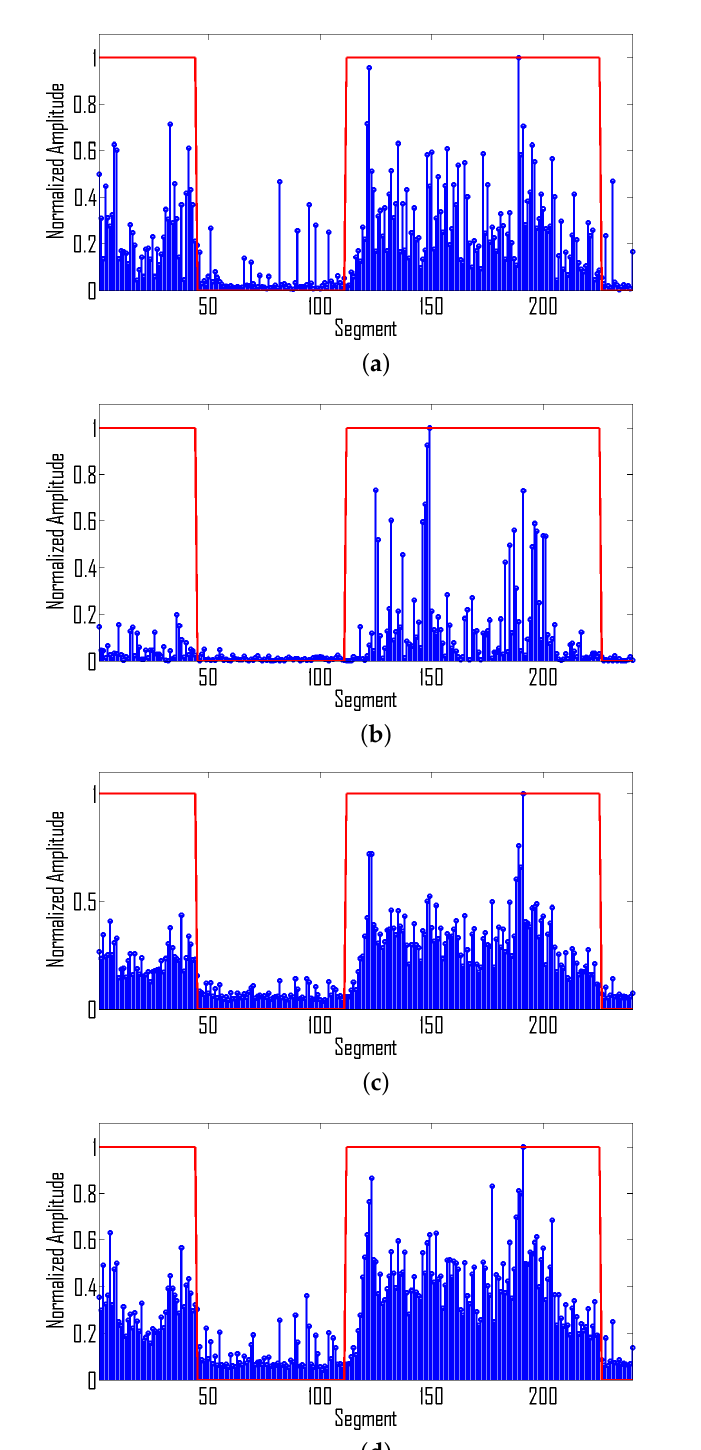
Figure 9. Illustration of feature variation during seizure activity: ( a ) Frequency marginal related feature, i.e., F 1 , ( b ) Time-marginal related feature, i.e., T 1 , ( c ) Mean of ρ FIL ( t , f ) ( TF 1 ), ( d ) standard deviation of ρ FIL ( t , f ) ( TF 2 )